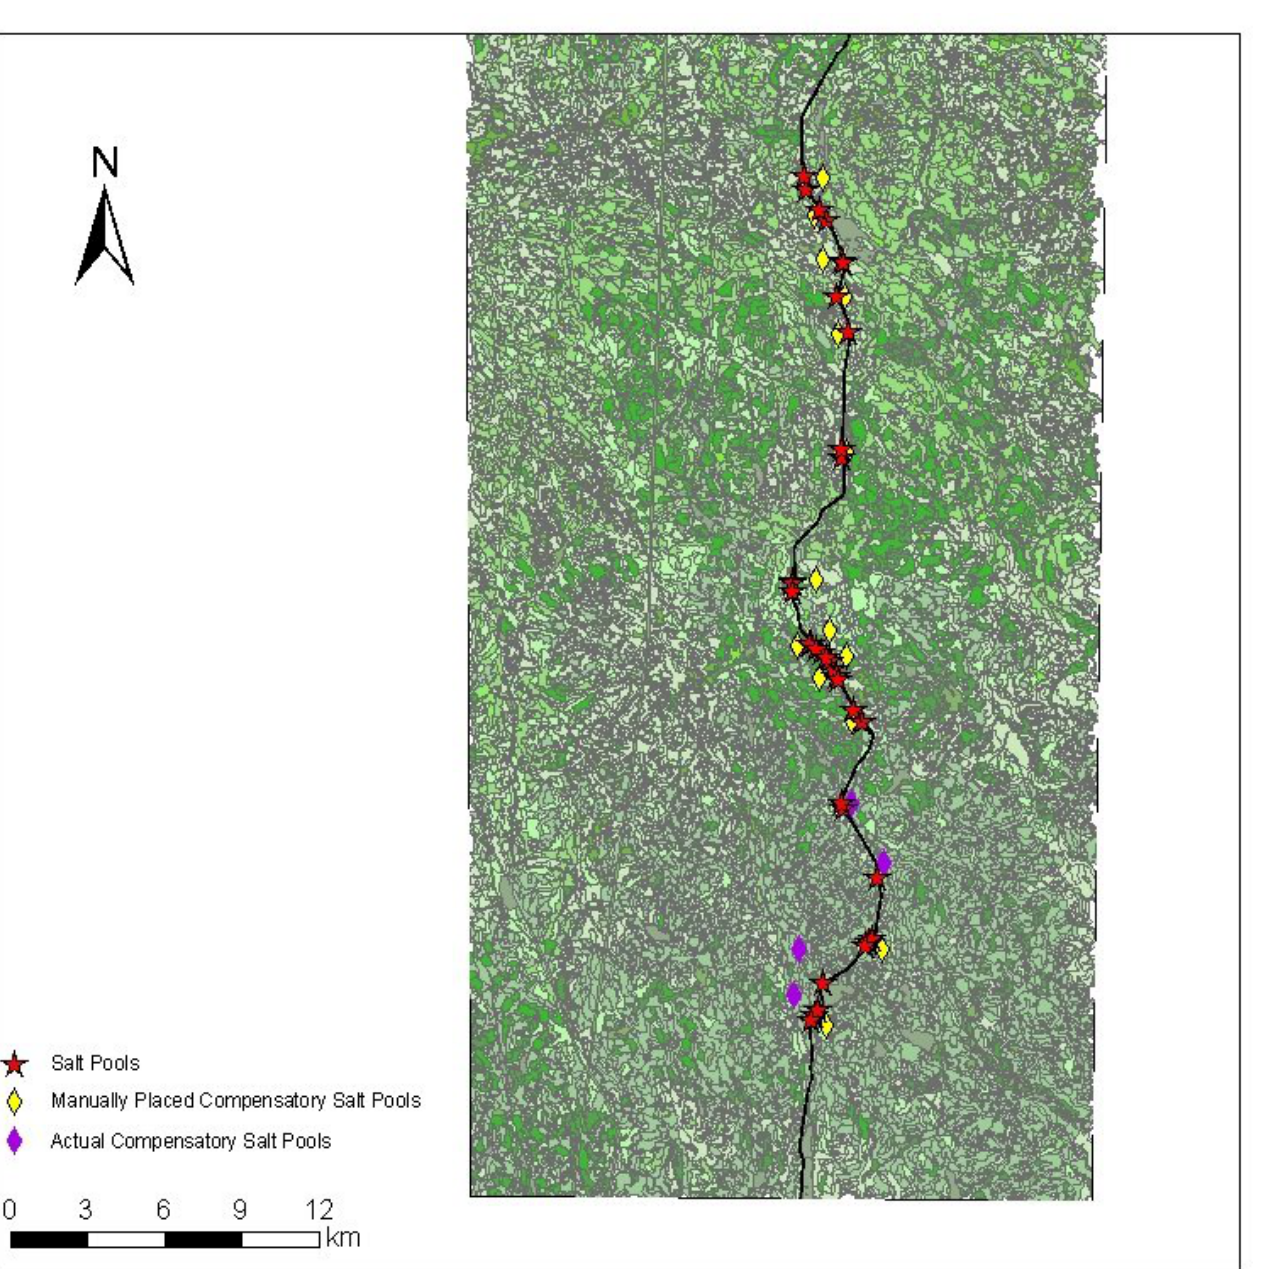
Fig. 7 . Location of the 36 roadside salt pools and their 18 compensatory salt pools in the model’s study area along Route 175 in the Laurentides Wildlife